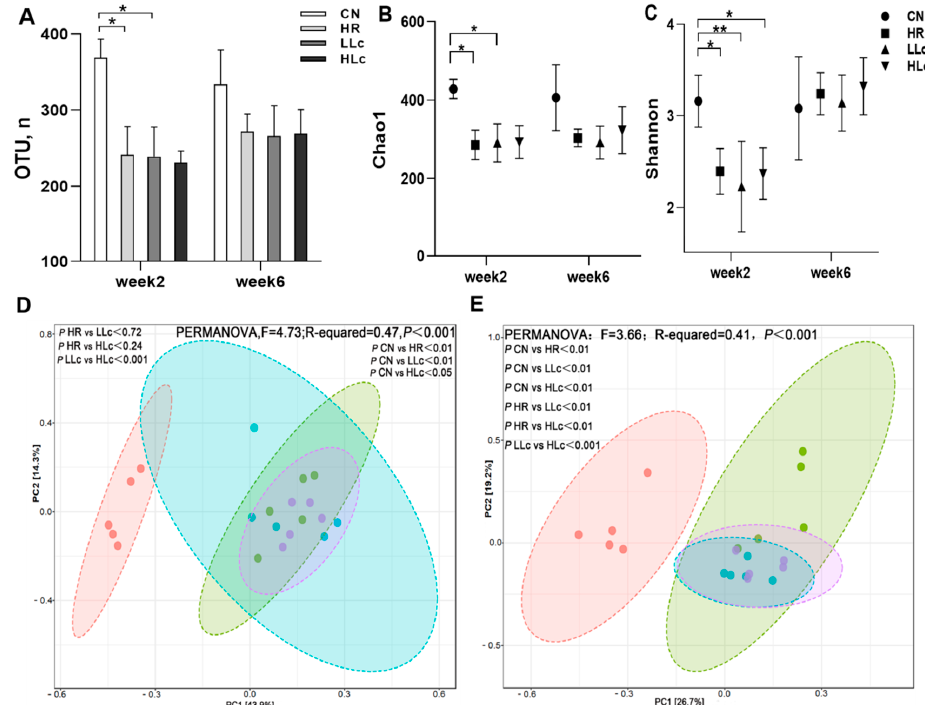
Figure 3. Lactobacillus casei improve the reduction of alpha and beta diversity induced by anti-TB drugs. Alpha diversity:( A ) OUT numbers ( B ) Chao1 index ( C ) Shannon index at two-week and six-week. PCA based on unweighted UniFrac distance to compare the similarity of species types between groups: ( D ) PCoA based on unweighted uniFrac distance on OTU level, week 2; ( E ) PCoA based on unweighted uniFrac distance on OTU level, week 6. Permutational multivariate analysis of variance in weighted UniFrac similarity coefficient (PERMANOVA) was also performed ( D , E ). N = 5 in each group, values are presented as the mean ± SD, * indicates p < 0.05, ** indicates p < 0.01. CN: control group, HR: isoniazid + rifampicin model group, LLc: HR + low dose L. casei group, HLc: HR + high dose L. casei group.